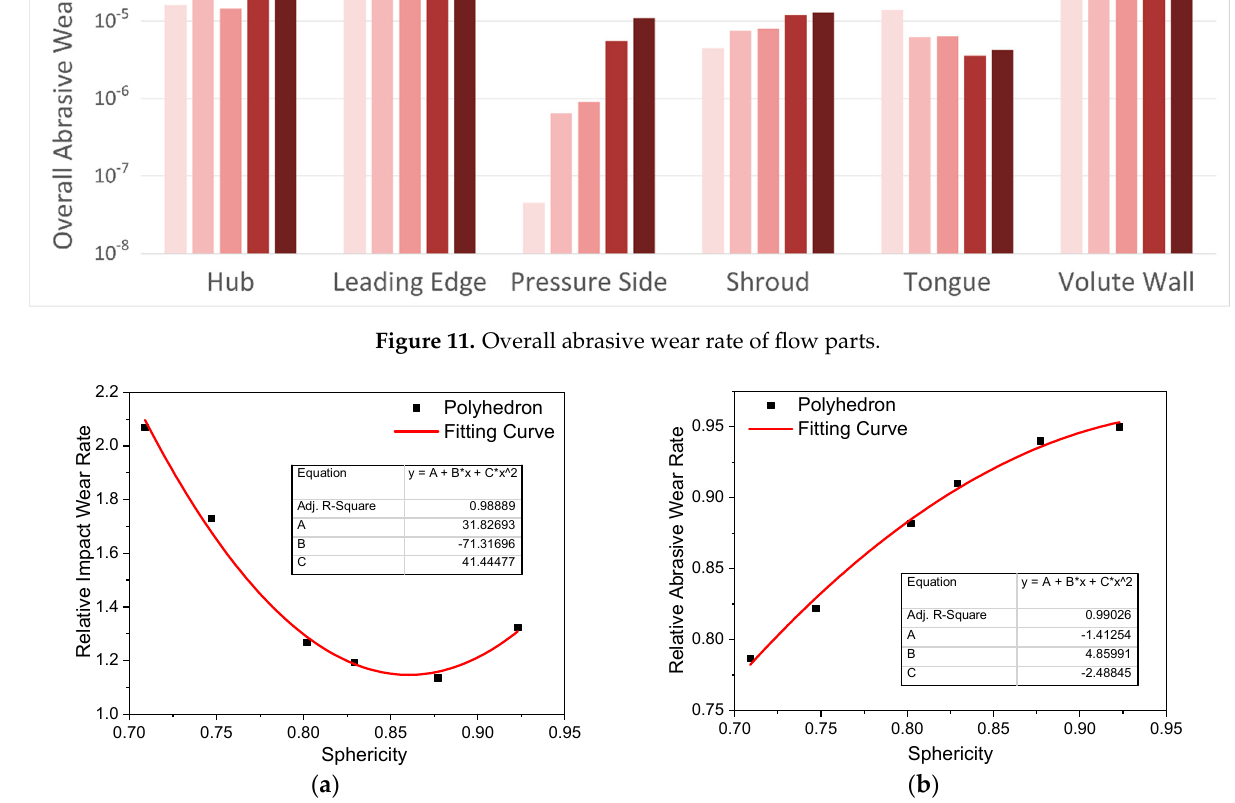
Figure 12. Regression equation for particle sphericity: ( a ) relative impact wear rate and ( b ) relative abrasive wear rate.